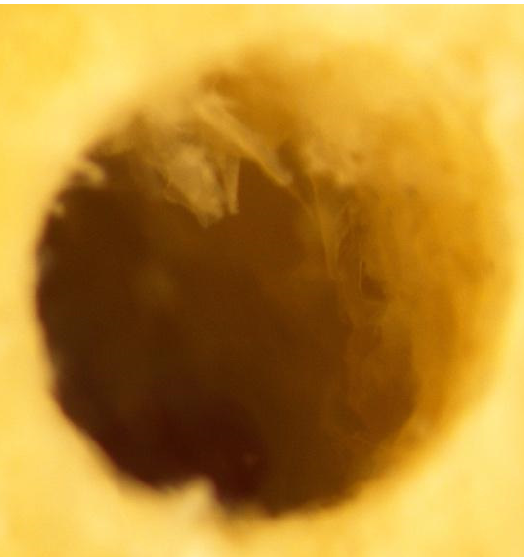
Figure 10. The MIS ® drills’ tibial section under the Nikon ® stereomicroscope. Irregularities can be seen over the osteotomy walls, suggesting non-condensed cortical bone.